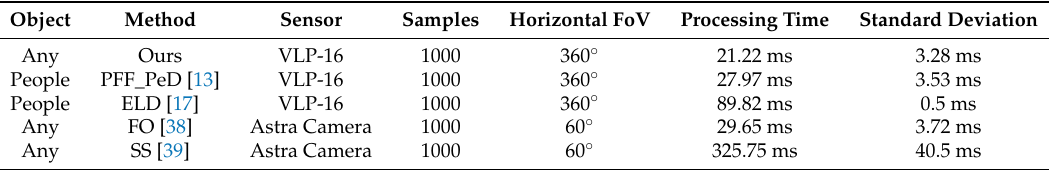
Table 3. Average time employed by the different tested algorithms for processing the sensor readings and detecting